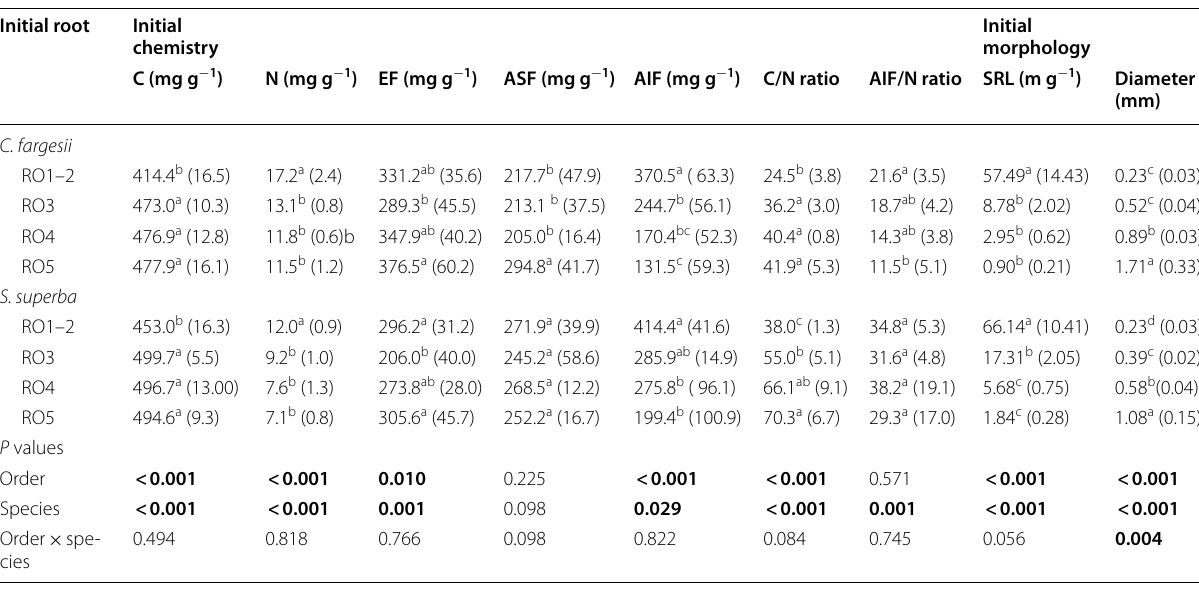
Table 2 Initial tissue chemistry and morphology of different-order roots at the beginning of litterbag experiment for the two subtropical tree species (mean with SE in parentheses, n